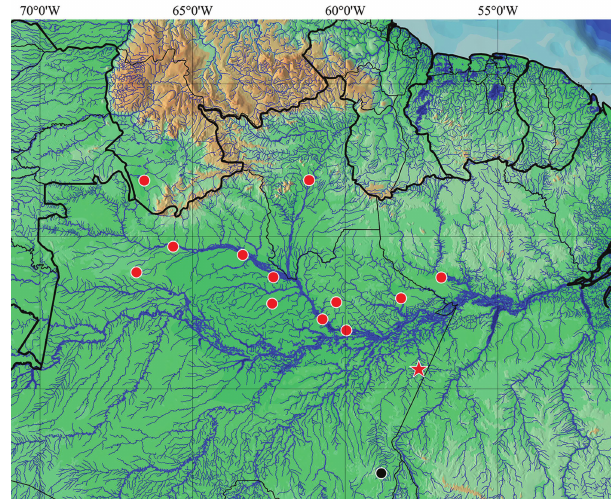
Fig. 8. Map of northern South America, including northern Brazil and southern Venezuela, showing distribution of Metynnis melanogrammus . The red star represents the type locality, red circles represent the paratype localities, and the black circle represents the locality on the rio Surunduri at which the live photograph of the new species (Fig. 7) was